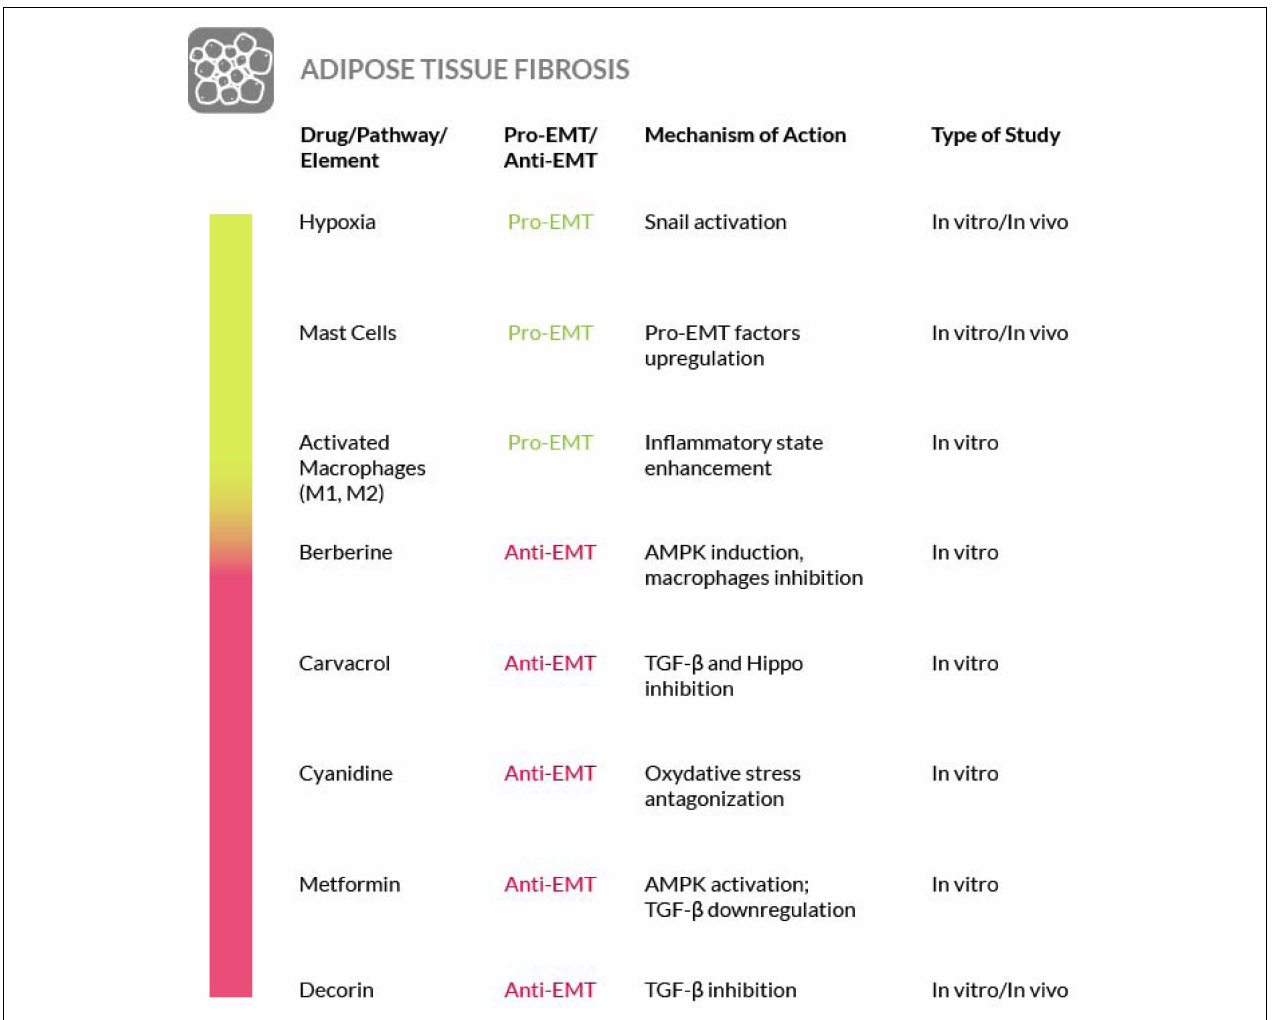
FIGURE 10 | Most relevant molecular mechanisms and possible drugs for the treatment of EMT in adipose tissue fibrosis.